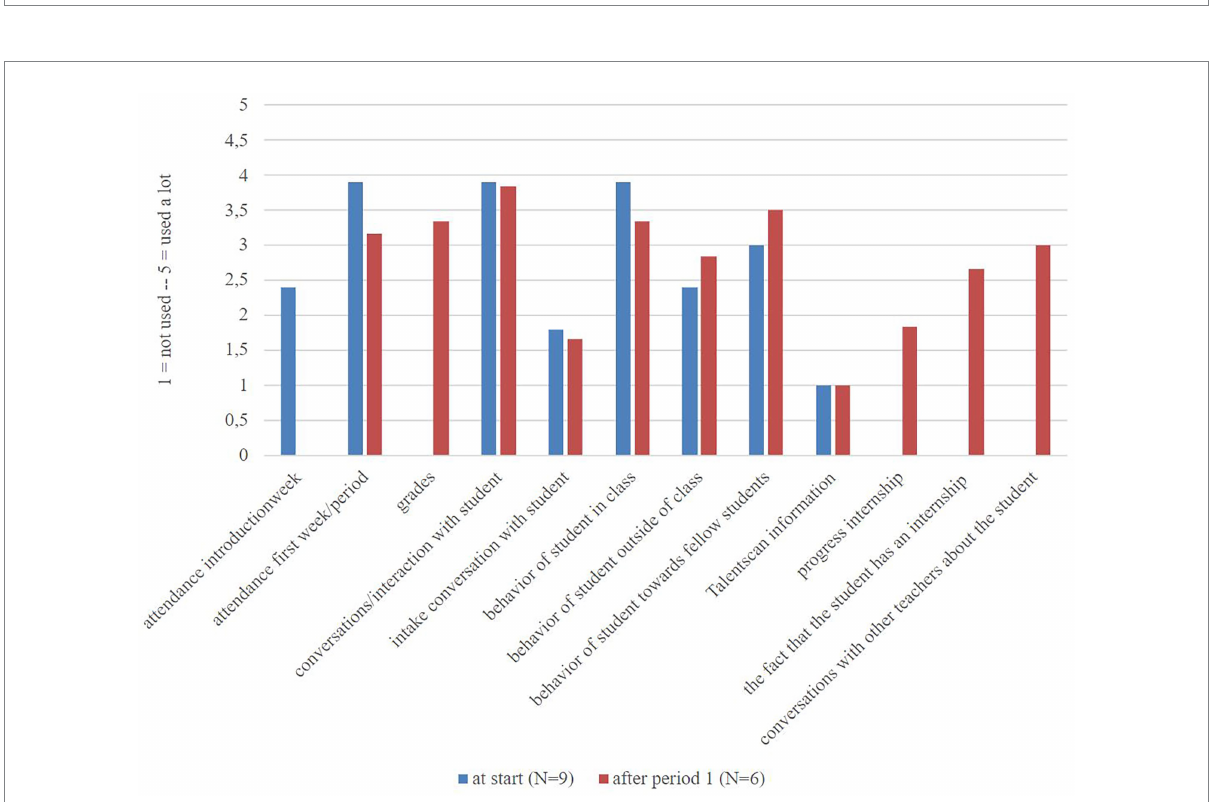
FIGURE 4 Teachers’ answers to questions about which observations, feelings, or hunches entered their estimations on a 5-point Likert scale at the start ( N = 9) and after period 1 ( N =